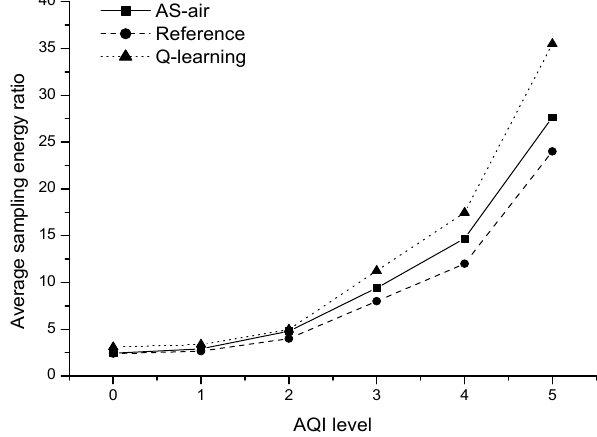
Figure 7. The average sampling energy ratio with different Air Quality Index (AQI) level.